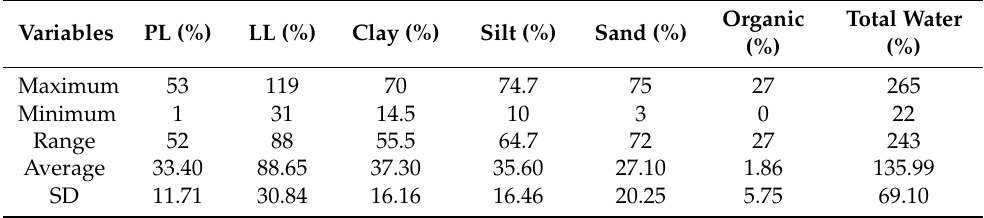
Table 2. Statistical analysis of